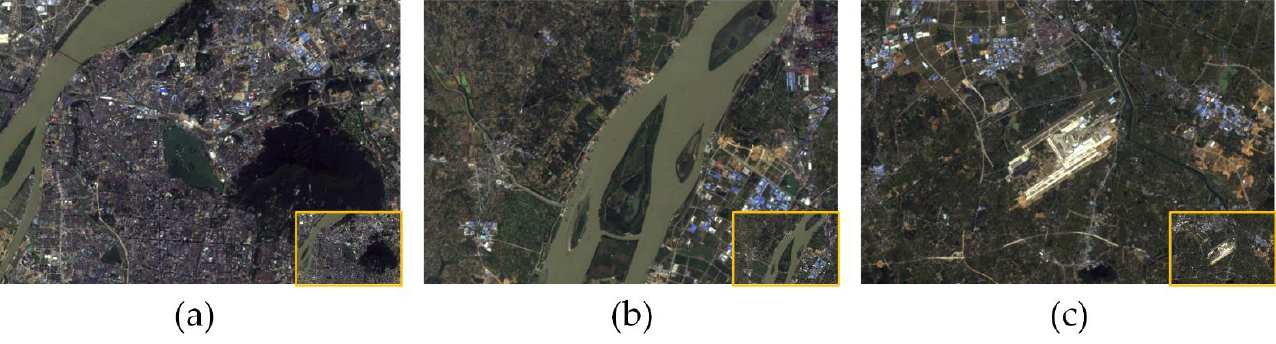
Figure 11. The visual results of the landscapes around ( a ) Xuanwu Lake, ( b ) Xinjizhou National Wetland Park, and ( c ) Lukou International Airport in Nanjing from the Landsat-8 dataset, with upscale factor 4 generated by our method. The small pictures in the right button corner are the low-resolution images, and the larger ones are high-resolution images.